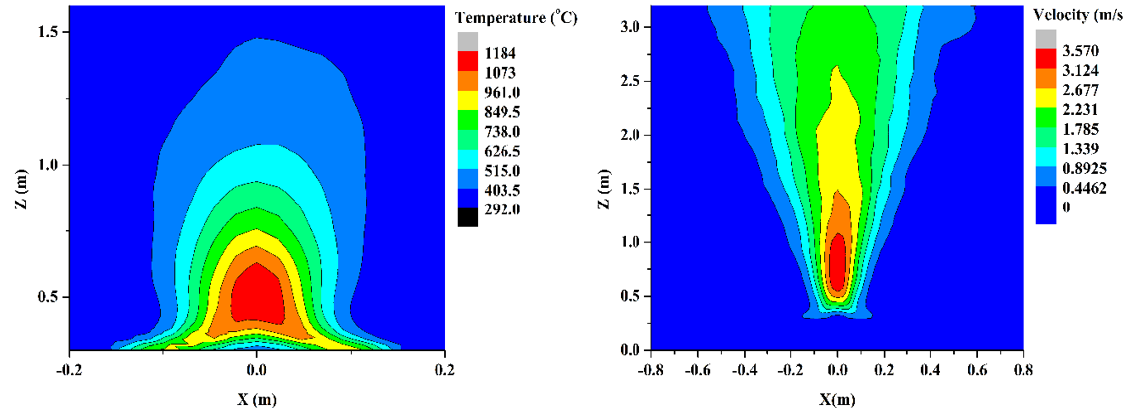
Figure 4. Average velocity profile for 31 cm methanol pool fire.